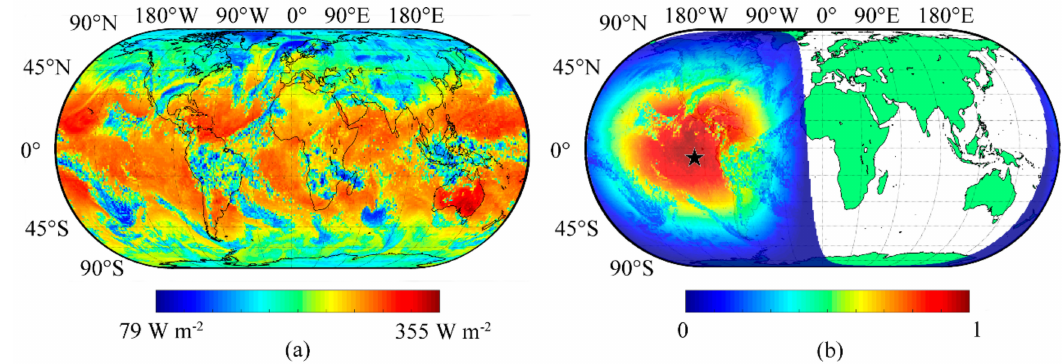
Figure 7. Distribution of ( a ) outgoing long-wave radiation (OLR) derived from GEOS-5 and ( b ) normalized OLR contribution of the elements in the observational scope observed from a Moon-based platform at 0:00 UTC on 2 January